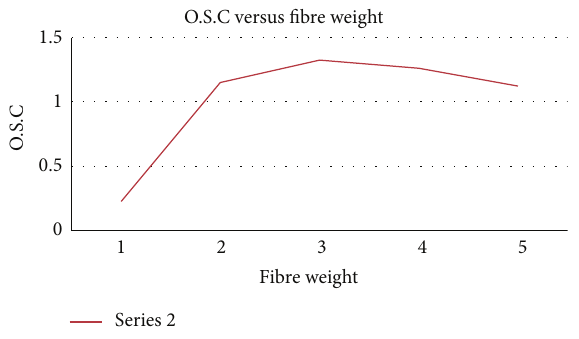
Figure 5: Oil sorption capacity versus fibre weight.